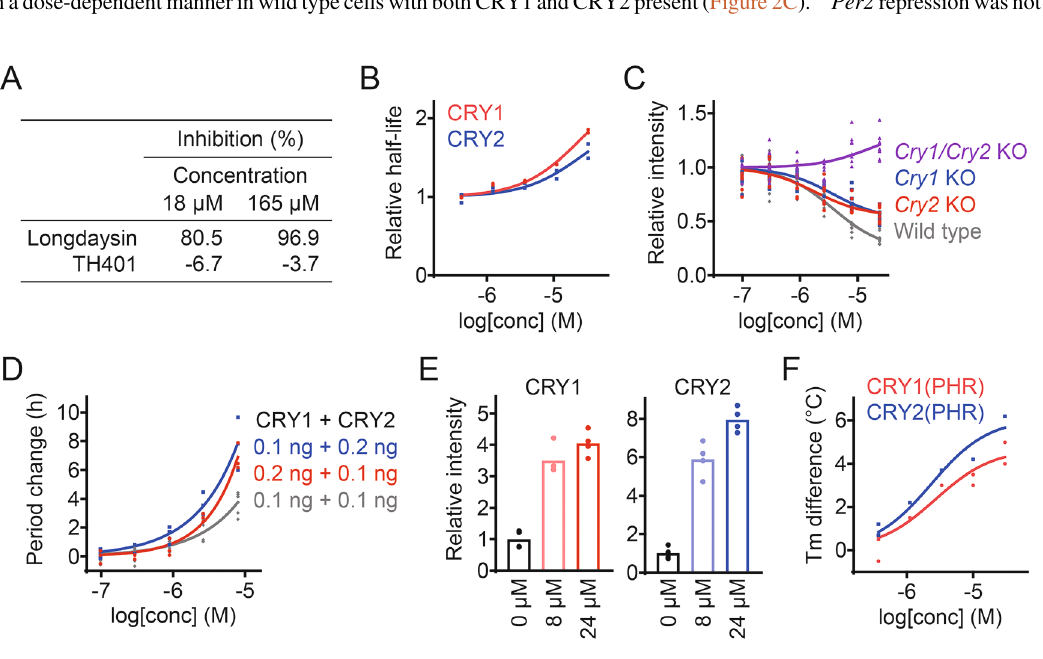
Figure 2. TH401 stabilizes and interacts with CRY1 and CRY2. (A) Effect of TH401 on casein kinase I δ (CKI δ ) activity in vitro. Kinase activity was analyzed in the presence of various concentrations of compounds ( n = 1). Longdaysin